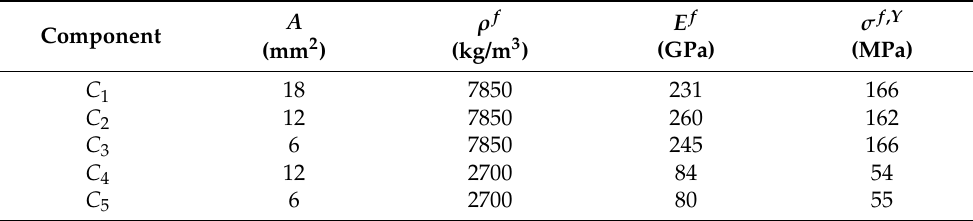
Figure 9. Application of the sorting conditions (a) and (c). Table 4. The set of components for optimization ( C